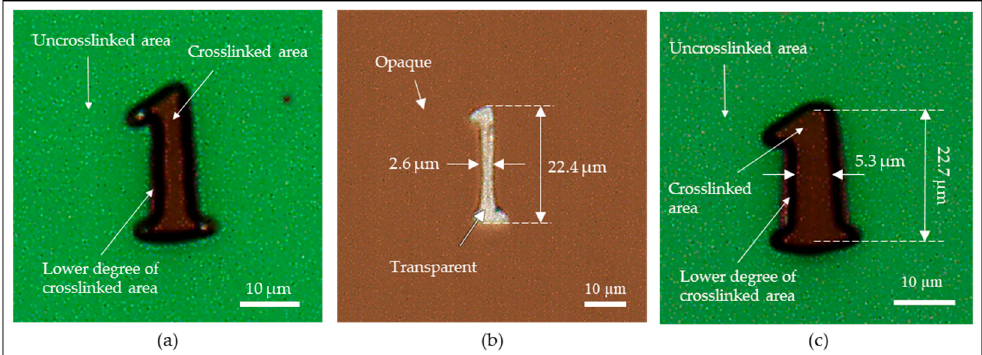
Figure 10. Results of the projection lithography experiment: ( a ) a photo-reduced pattern ‘1’ before etching process; ( b ) a photo-reduced pattern ‘1’ after etching process on a chromium glass; ( c ) an overexposed photo-reduced pattern ‘1’ with a measured linewidth of 5.3 µm before etching process.